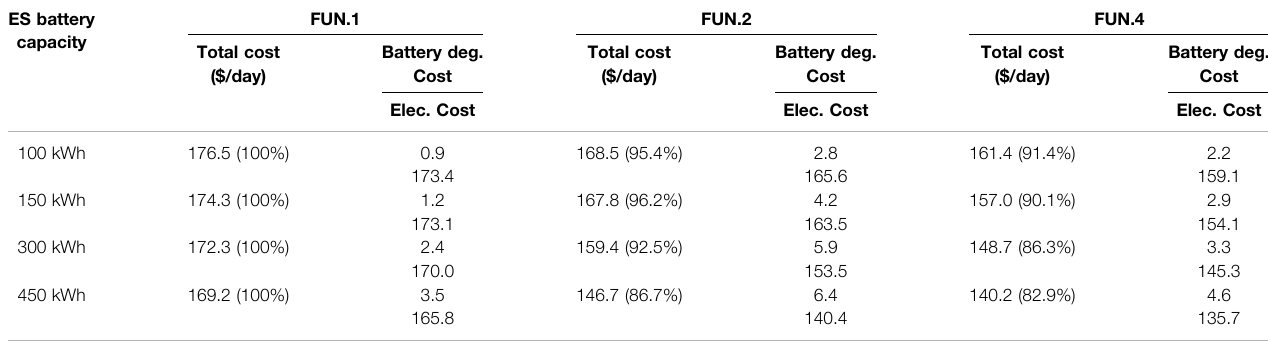
TABLE 3 | Operation cost of station under battery capacity sensitivity study. ES battery capacity